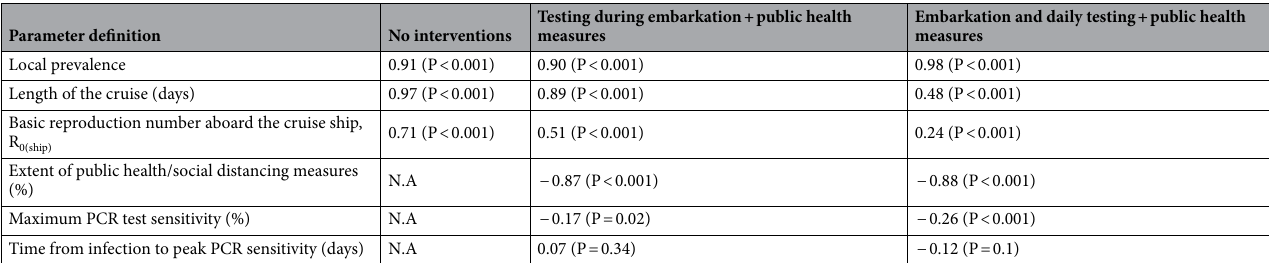
Table 2. Partial rank correlation coefficients (PRCC) derived from global sensitivity analyses that quantify the influence of the model parameters on the average final case load.